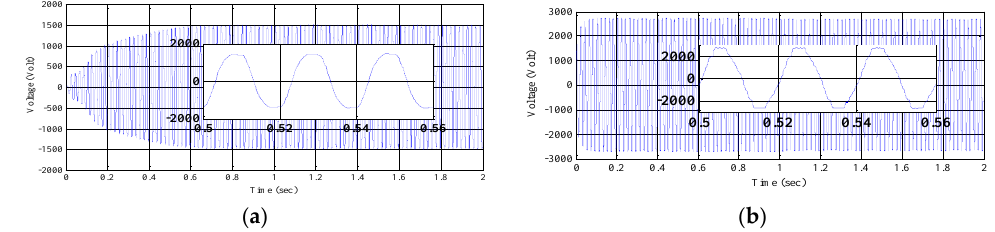
Figure 15. Overall output voltage of PV based 9-level CHB-MLI obtained using with filter and using ( a ) P&O MPPT ( b ) FLC MPPT technique. Technologies 2018 , 6 , x FOR PEER REVIEW